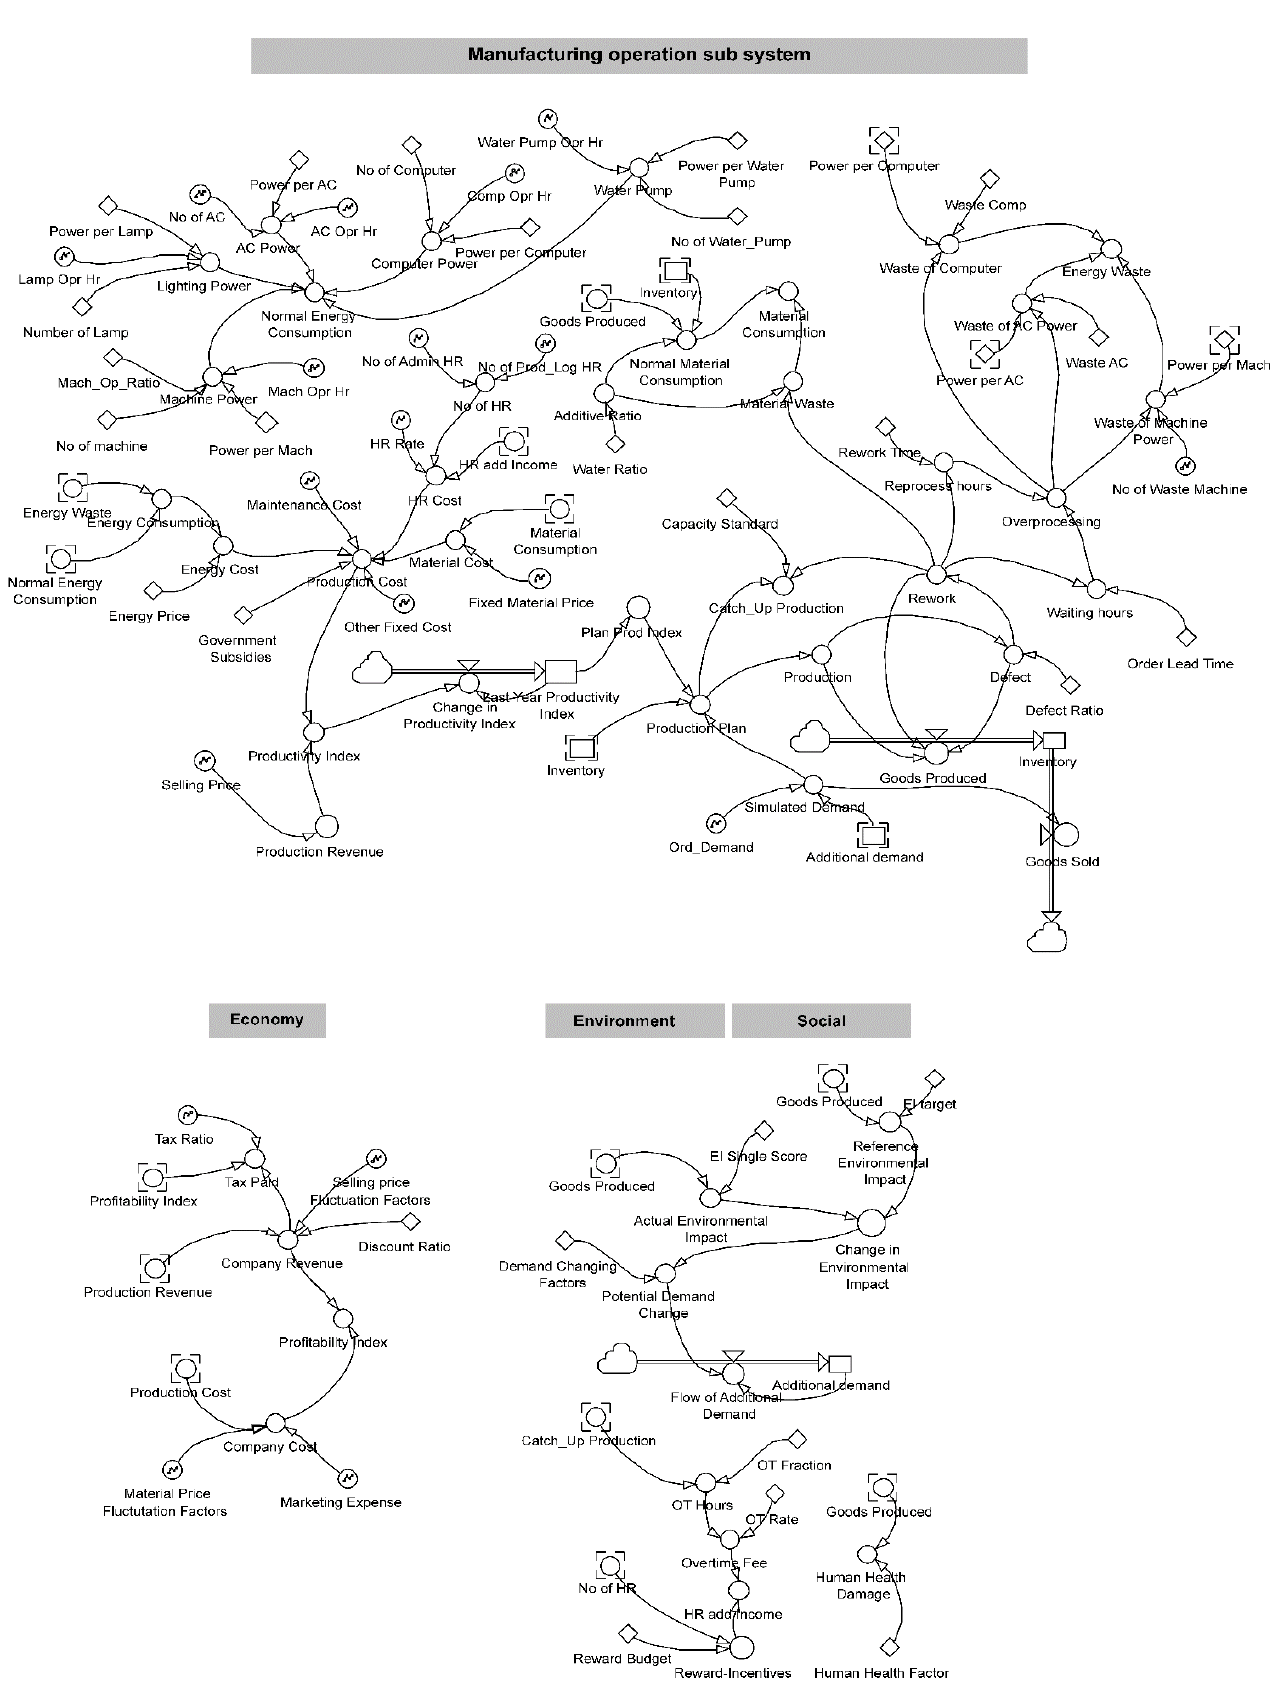
Figure 6. Stock flow diagram of sustainable cosmetics small and medium industries.